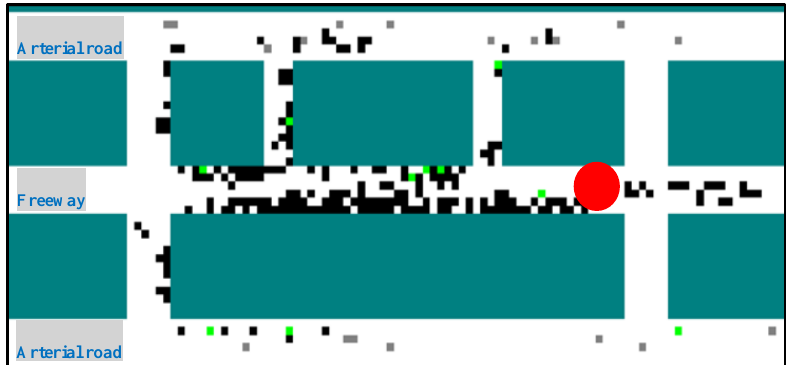
Figure 6. Screenshot of the simulation environment of the hypothetical road network.